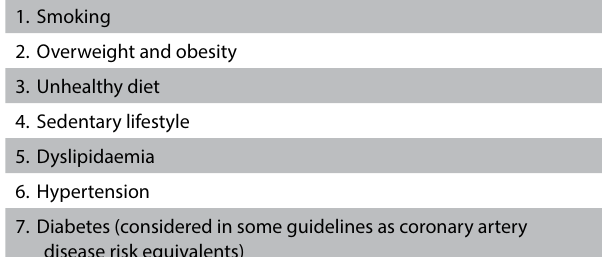
Table 1: Major for modifiable risk factors for coronary artery disease (CAD) 4 The following major risk factors for coronary artery disease are modifiable and should be considered in all adults: